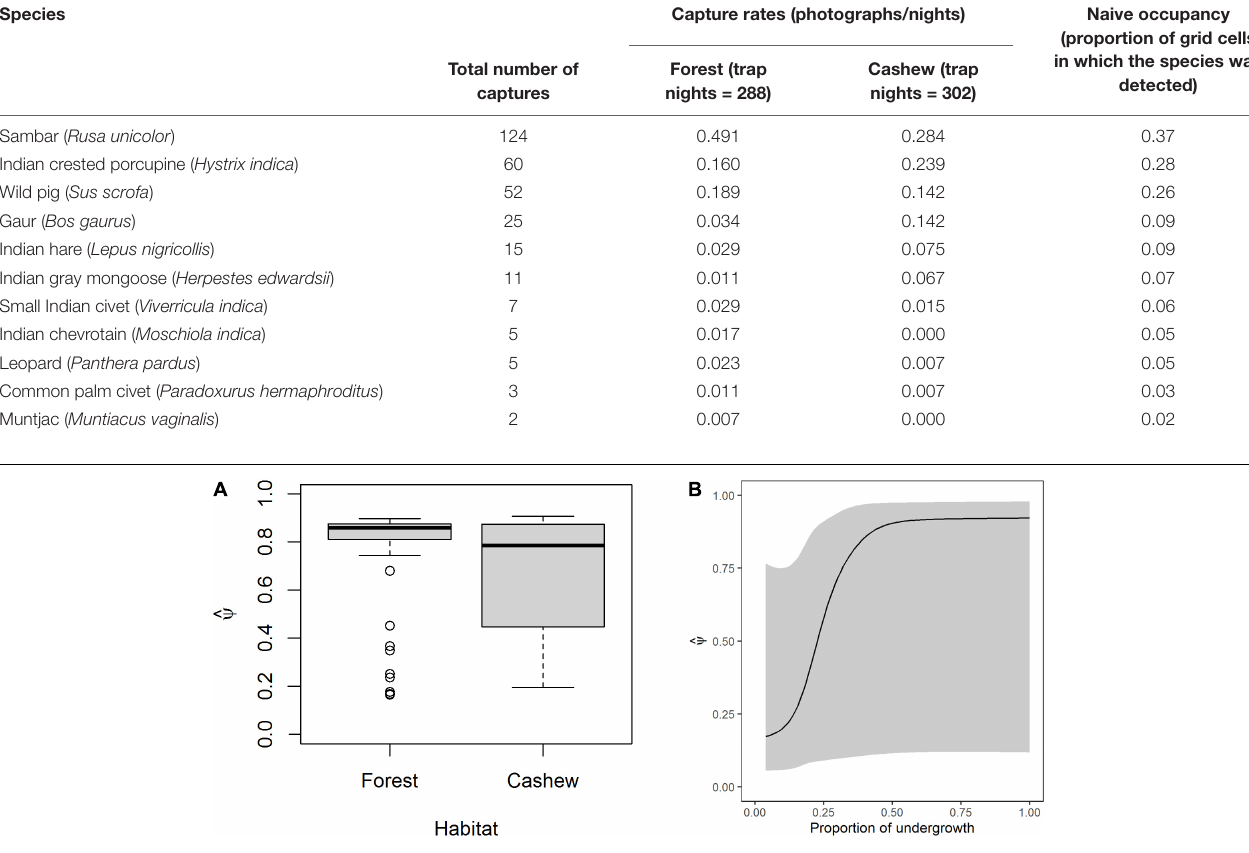
FIGURE 2 | Model-averaged estimates of habitat use of Indian crested porcupine as a function of (A) habitat type and (B) proportion of undergrowth.